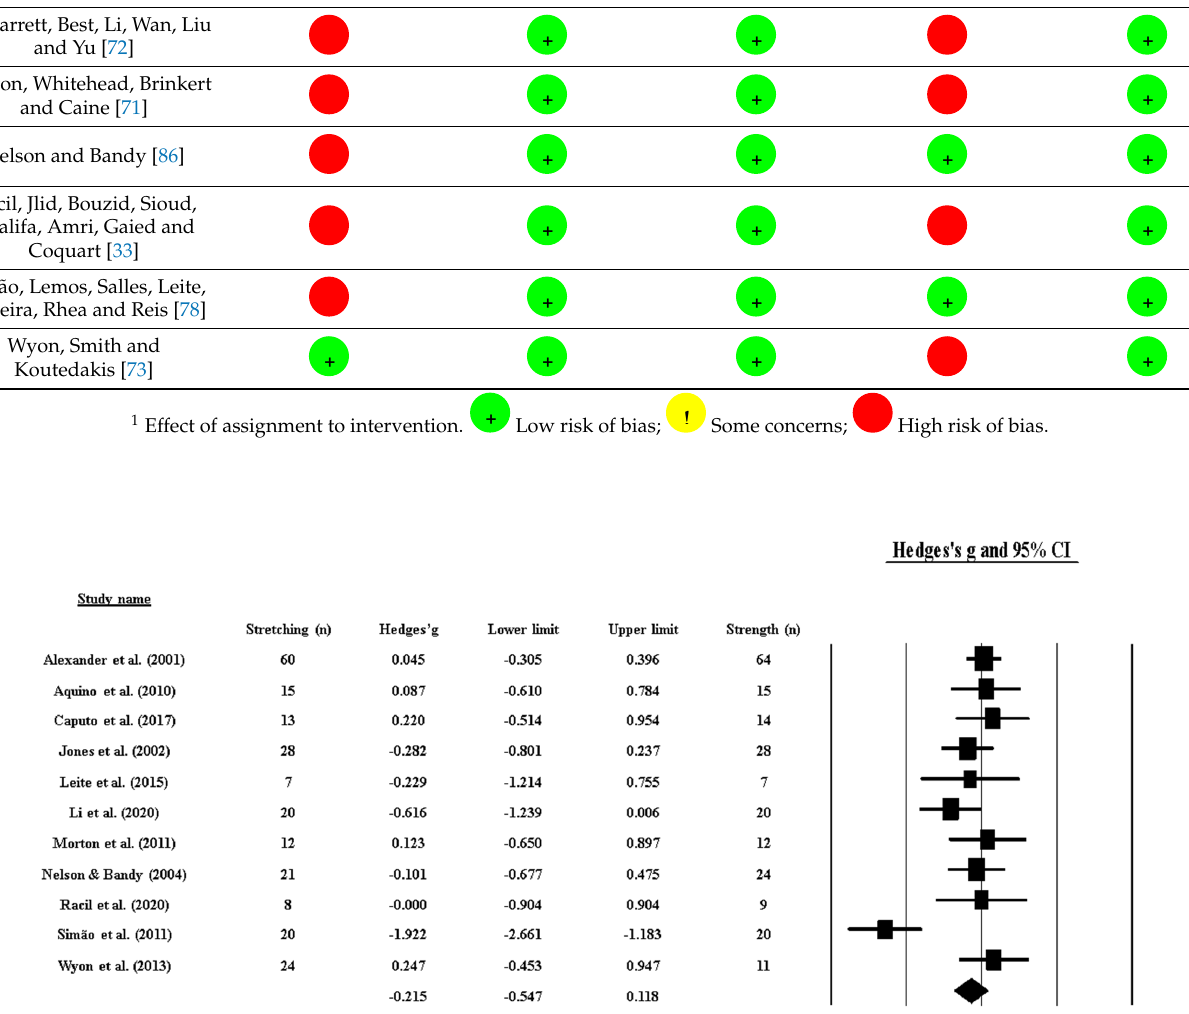
Table 2. Assessments of risk of bias (Cochrane’s RoB 2).